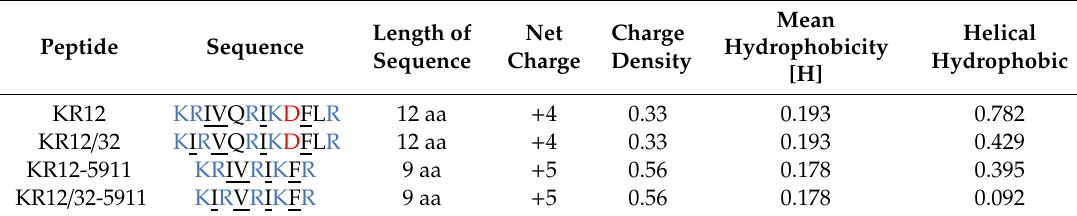
Table 1. Table showing the used peptides sequences, including their charge, hydrophobicity, and amphiphacity, determined by hydrophobic characteristics. Within the sequences, positively charged residues are marked in blue, the negatively charged in red, and highly hydrophobic sequences are